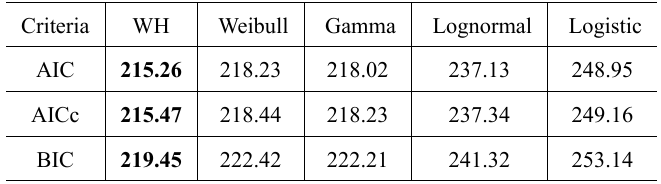
Results of AIC, AICc and BIC criteria for all fitted distributions considering the dataset related to the failure time of 60 electrical appliances.